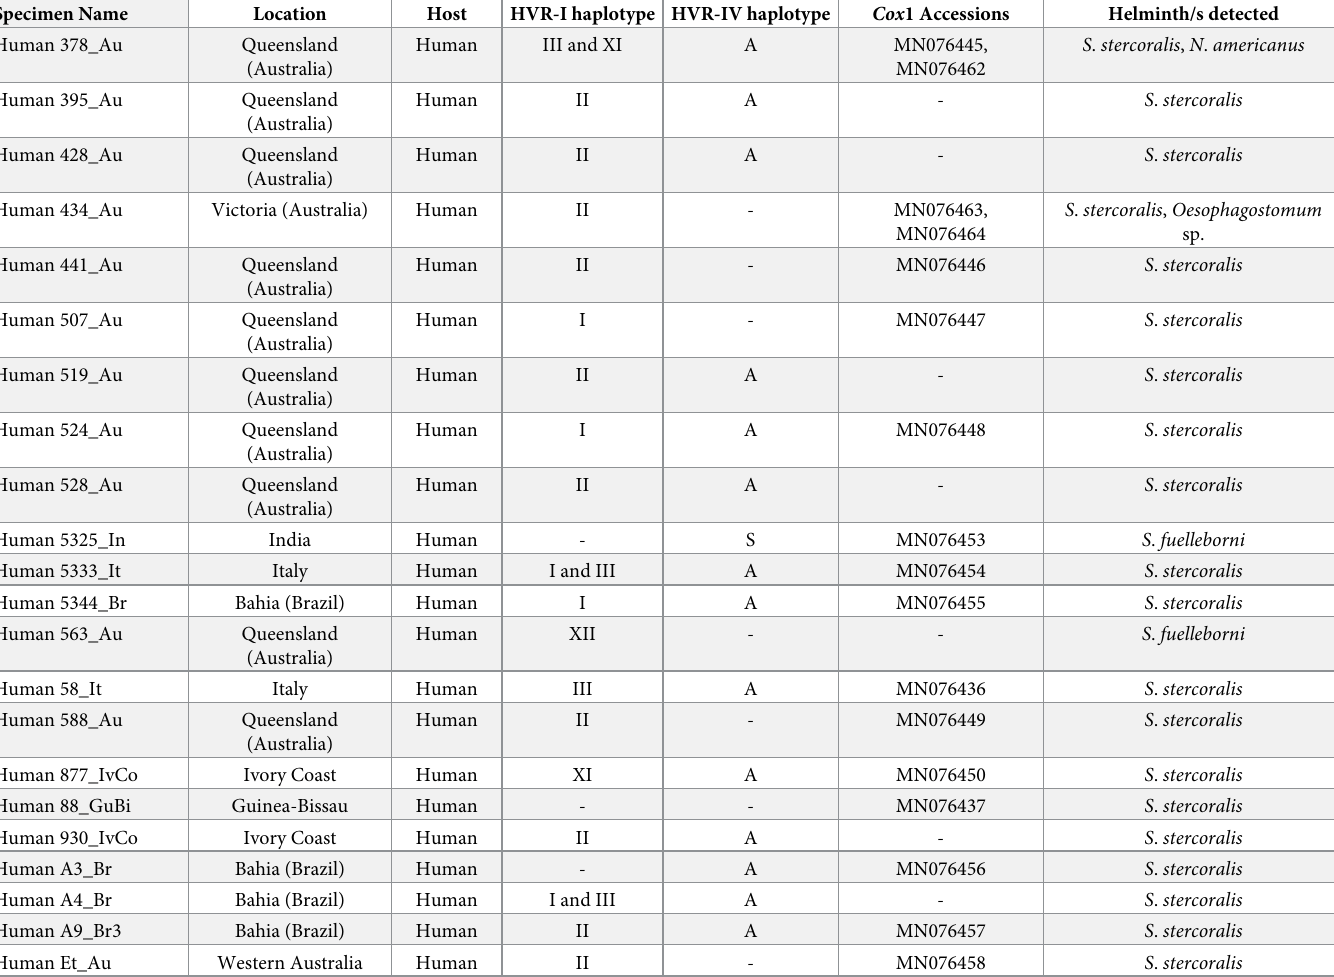
reported amplification of cox1 DNA from Ancylostoma sp., as well as Metastrongylus sp., possi- bly some free-living nematodes, and a rotifer (Fig 4) [21], using this assay. A cox1 amplicon from an Australian specimen (Human 333_Au) contained reads from S . fuelleborni and Neca- tor americanus while another specimen (Human 378_Au) contained DNA from S . stercoralis and N . americanus . For other specimens, 18S data were generated for Strongyloides spp., though a cox1 sequence was generated for a strongylid only. In one of these instances where Strongy- loides 18S data was generated, a cox1 sequence was detected for N . americanus only (Human 1_La). Similarly, for another specimen with Strongyloides 18S data (Human 434_Au), two cox1 sequences putatively belonging to an Oesophogostomum sp. were obtained (Fig 4). For a third specimen (Human 2_Ca), a sequence was generated for S . stercoralis 18S HVR-I and while